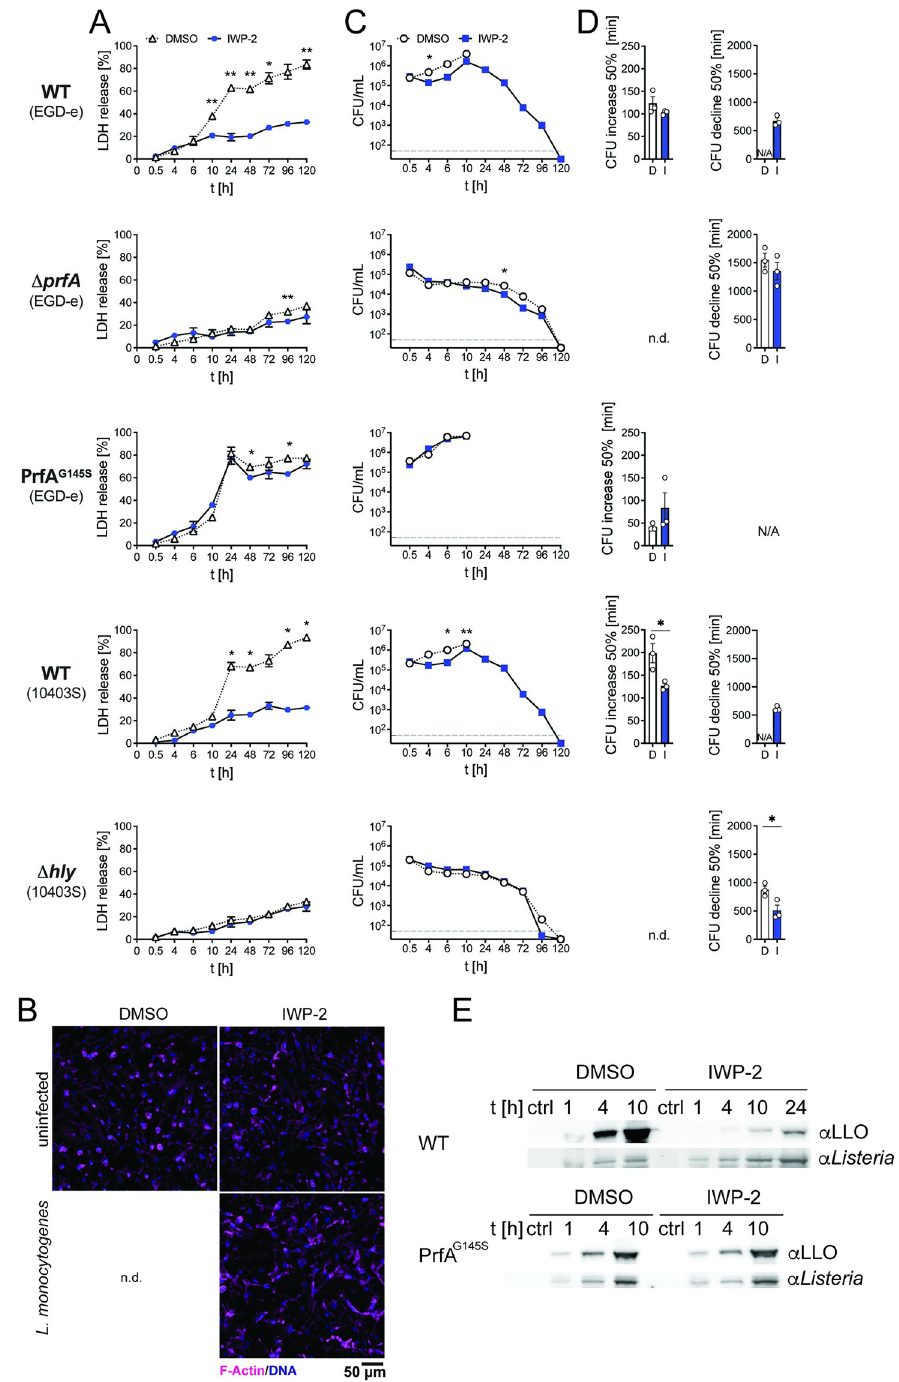
Fig 3. PrfA inhibition facilitates survival of infected macrophages alongside rapid expansion but ultimate elimination of intracellular L . monocytogenes . (A) Survival of BMM determined by LDH release assay upon infection with wild type (WT) L . monocytogenes EGD-e and 10403S, Δ prfA , PrfA G145S , and Δ hly in the presence of PrfA inhibitor IWP-2 (10 μ M) or DMSO (solvent control) at the indicated time points post-infection. Data are means +/- sem of 3 independent experiments, each performed in technical triplicates. Two-way ANOVA, Sidak multiple comparison test; � p < 0.05, �� p < 0.01. (B) Immune fluorescence images of BMM infected with wild type L . monocytogenes or left uninfected, in the presence of PrfA inhibitor IWP-2 (10 μ M) or DMSO at 5 days post-infection. No imageable cells remained in cultures infected in the presence of DMSO. Data are representative of at least three